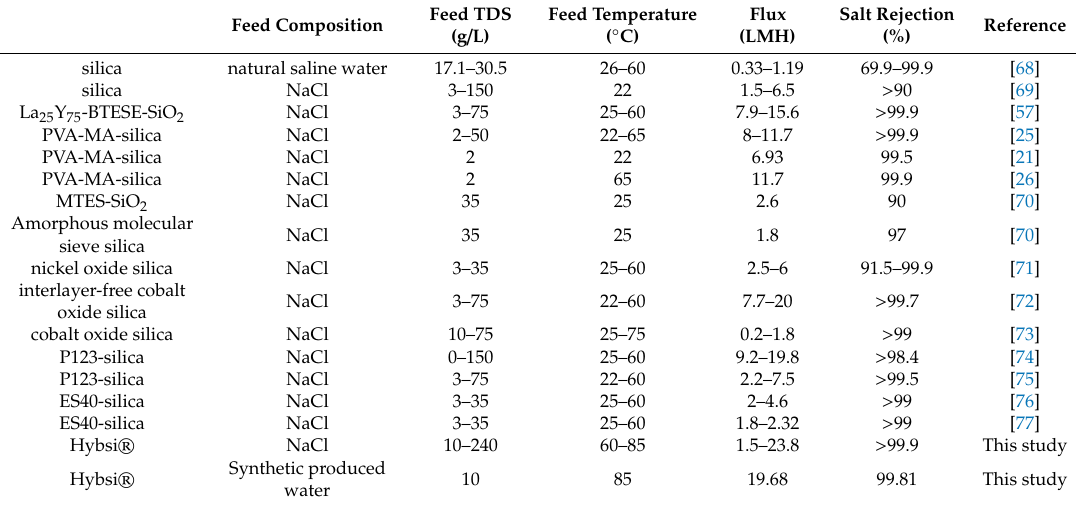
Table 6. Comparison of PVD process performance with silica-based